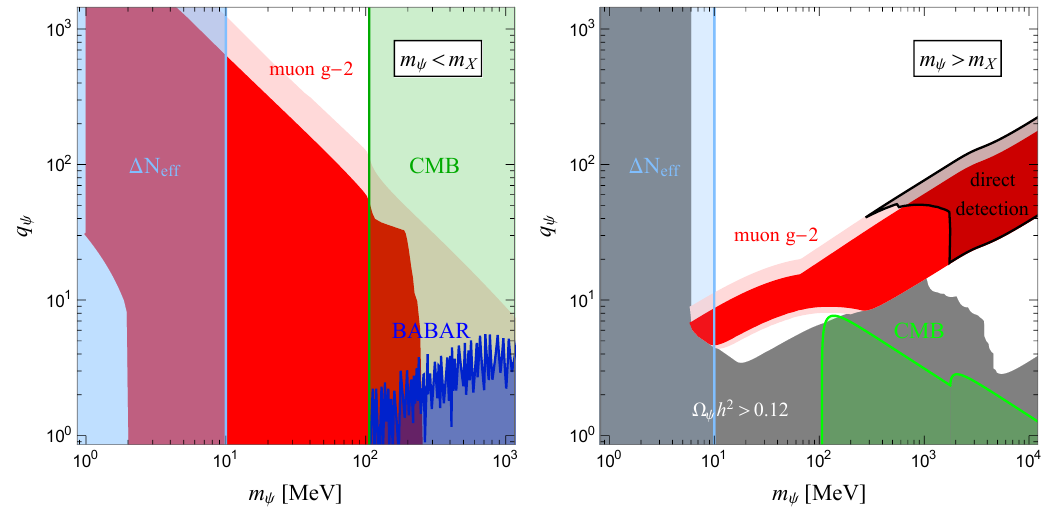
Figure 2 . The allowed parameter region in the plane of the DM parameters. Dark (light) red region is favored by the muon g (cid:0) 2 at 1 (cid:27) (2 (cid:27) ) level. Shaded regions are excluded by the CMB (green), (cid:1) N e(cid:11) (light blue) and direct detection (black) and BABAR (blue) experiments. Dark gray region is disfavored by the DM overabundance ((cid:10) h 2 > 0 :